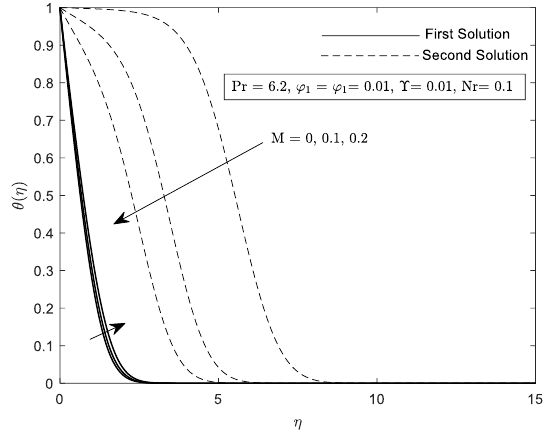
Figure 19. 𝜃(𝜂) on different 𝑀 .